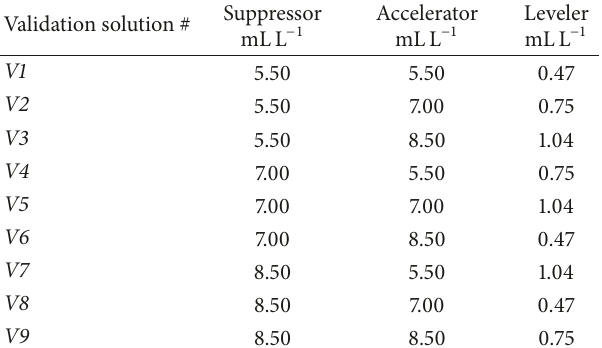
Table 2: Composition of the validation set